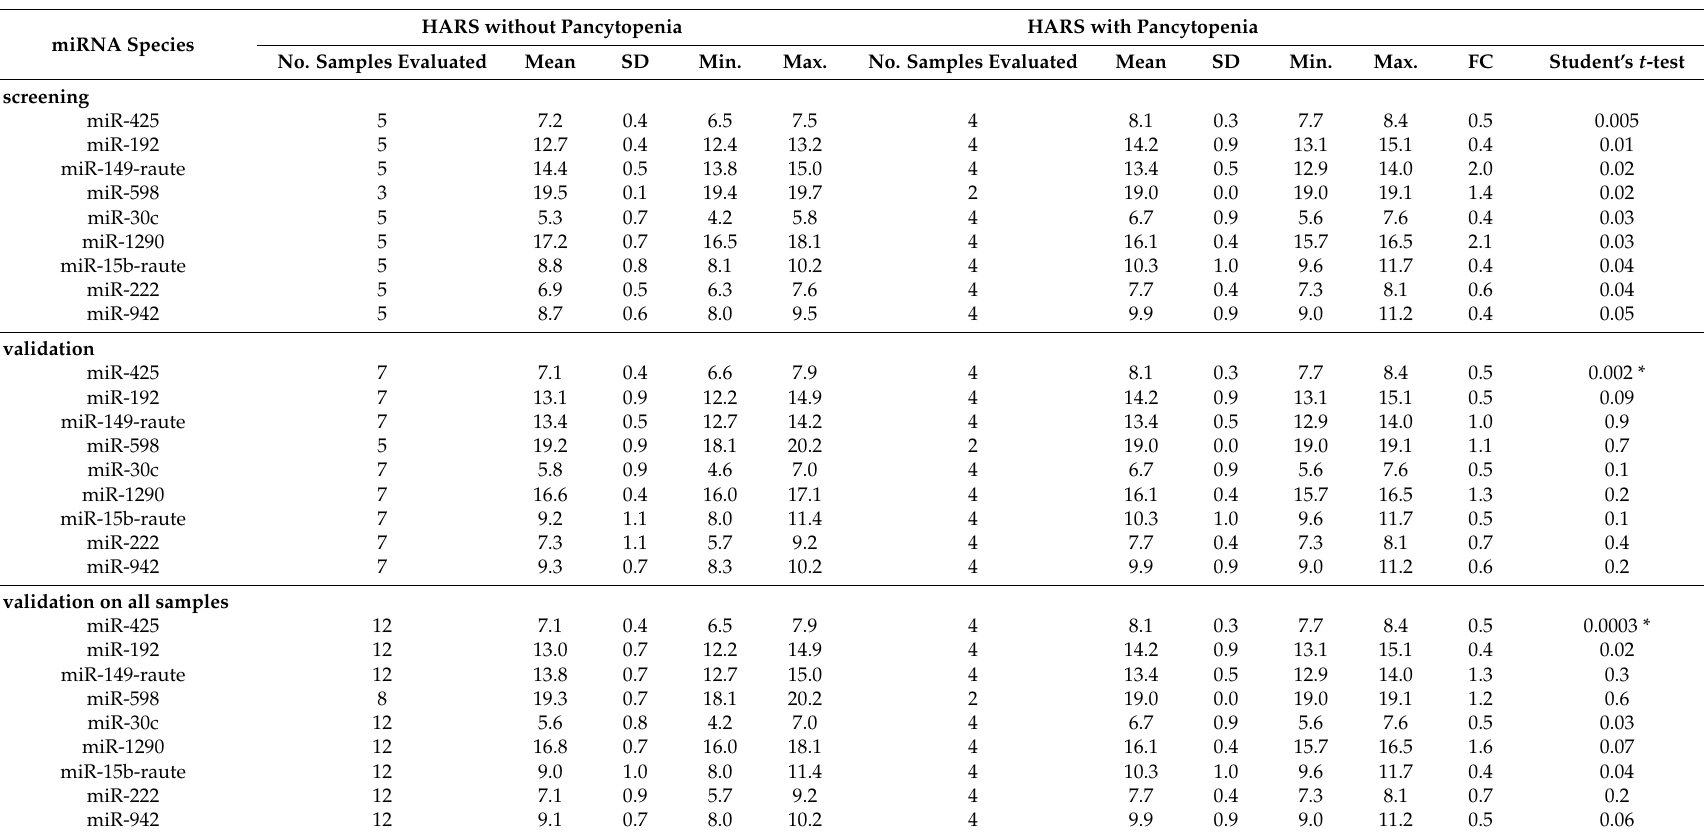
Table 2. Real-time quantitative polymerase chain reaction